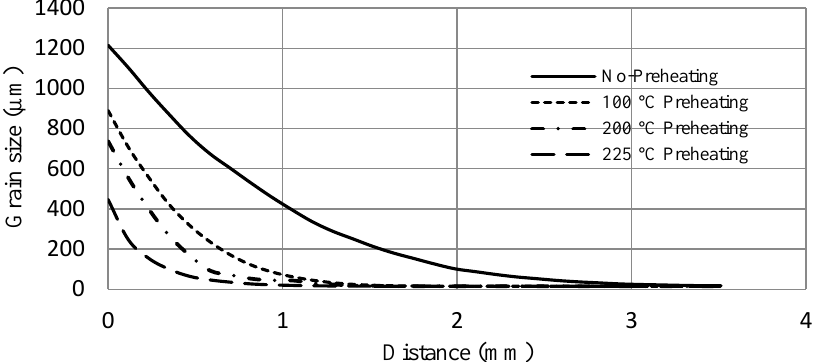
Figure 15. Distribution of average grain size at the mid transverse direction of the welding line through the HAZ for different states of preheating.